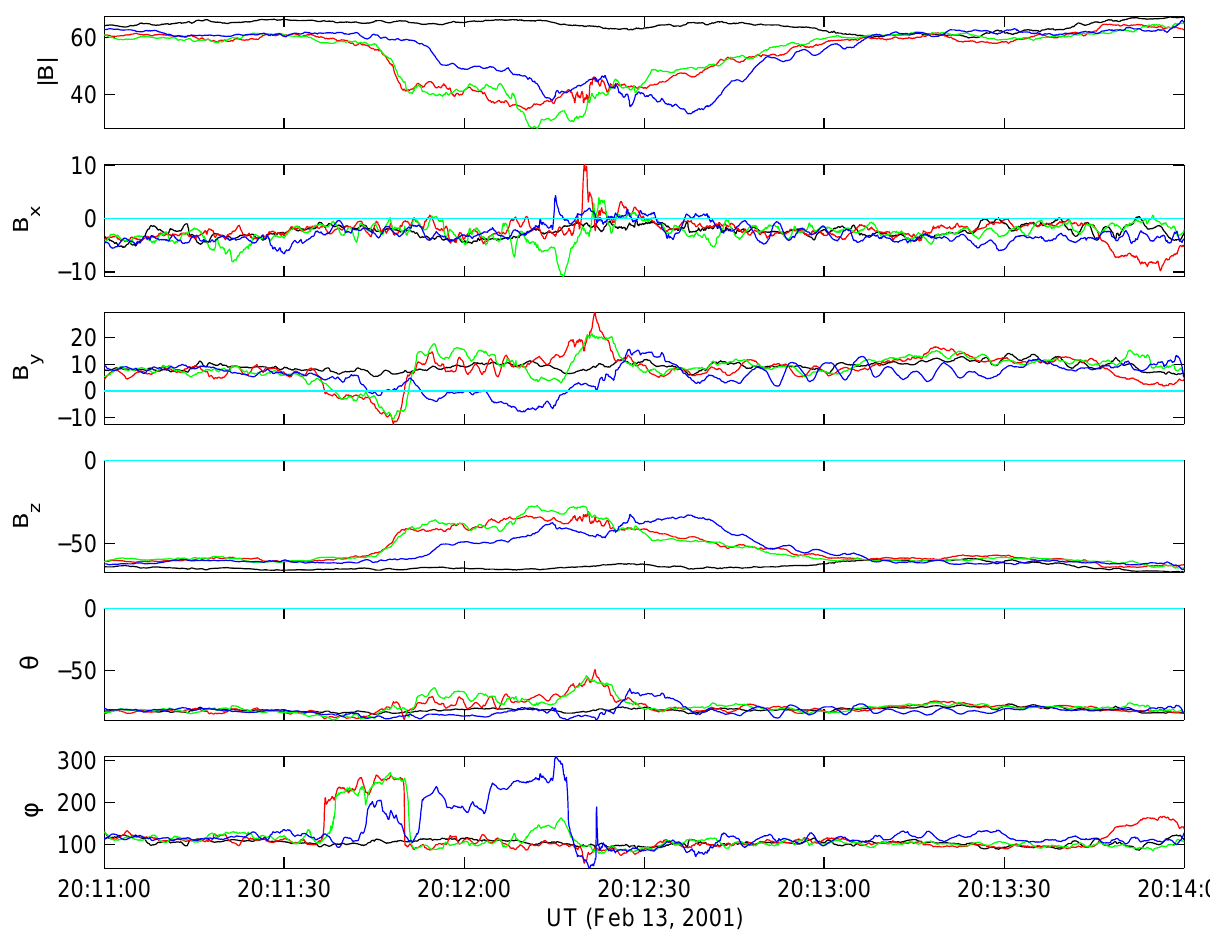
Fig. 9. FGM data in the interval 20:11–20:14. The format is the same as Fig. 6.